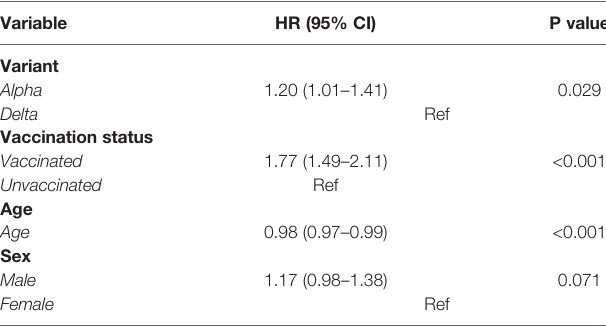
TABLE 2 | Hazards of discharge across variant